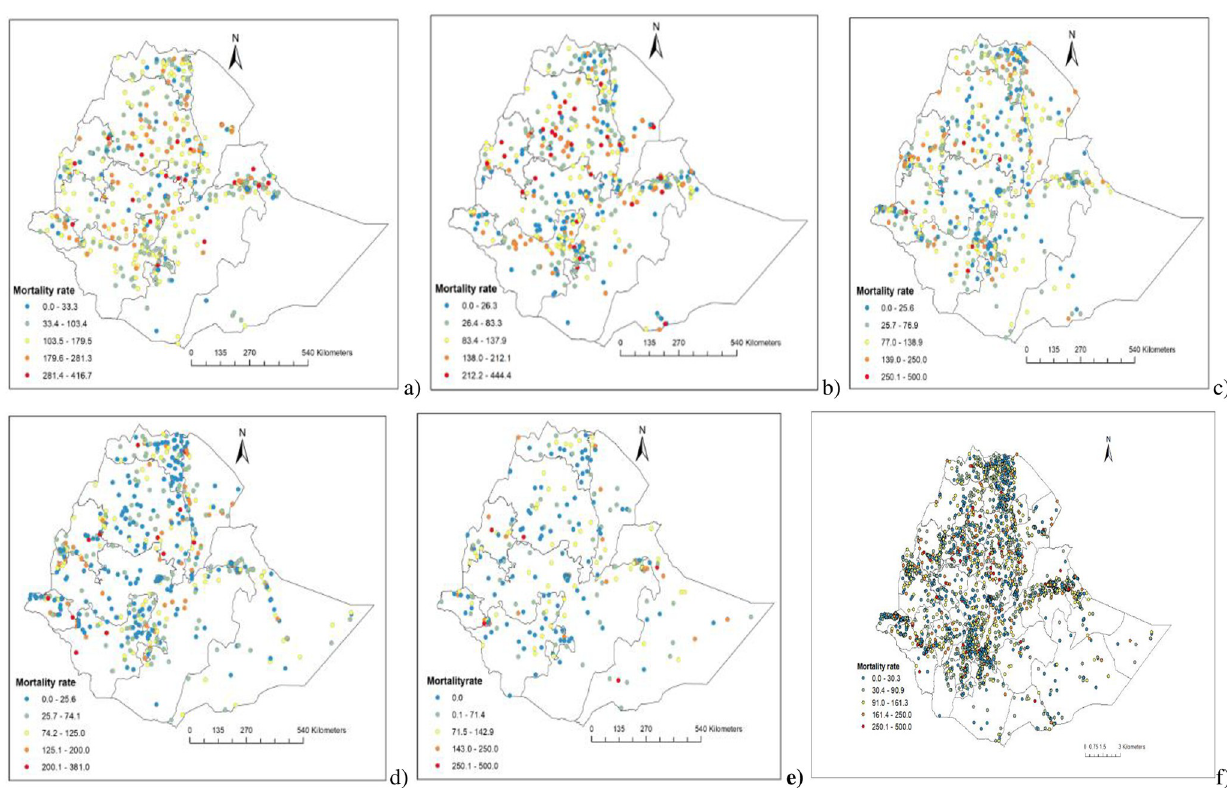
Fig 2. Geographical locations of data points and under-five mortality in Ethiopia: 2000(a), 2005(b), 2011(c), 2016(d), 2019(e) and 2000–2019 (f).